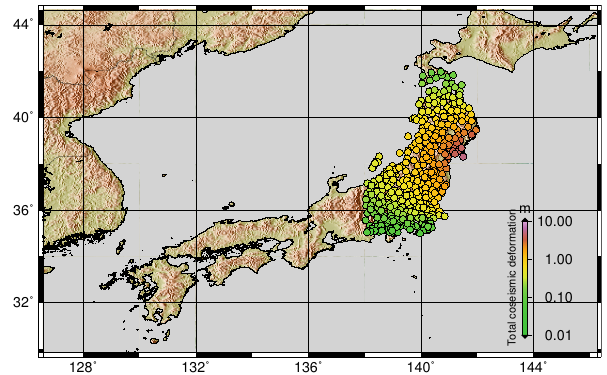
Figure 2. Coseismic slip distribution (Ozawa et al., 2011). Dis- placement in meters. Note the dynamical range of data spanning 4 orders of magnitude.